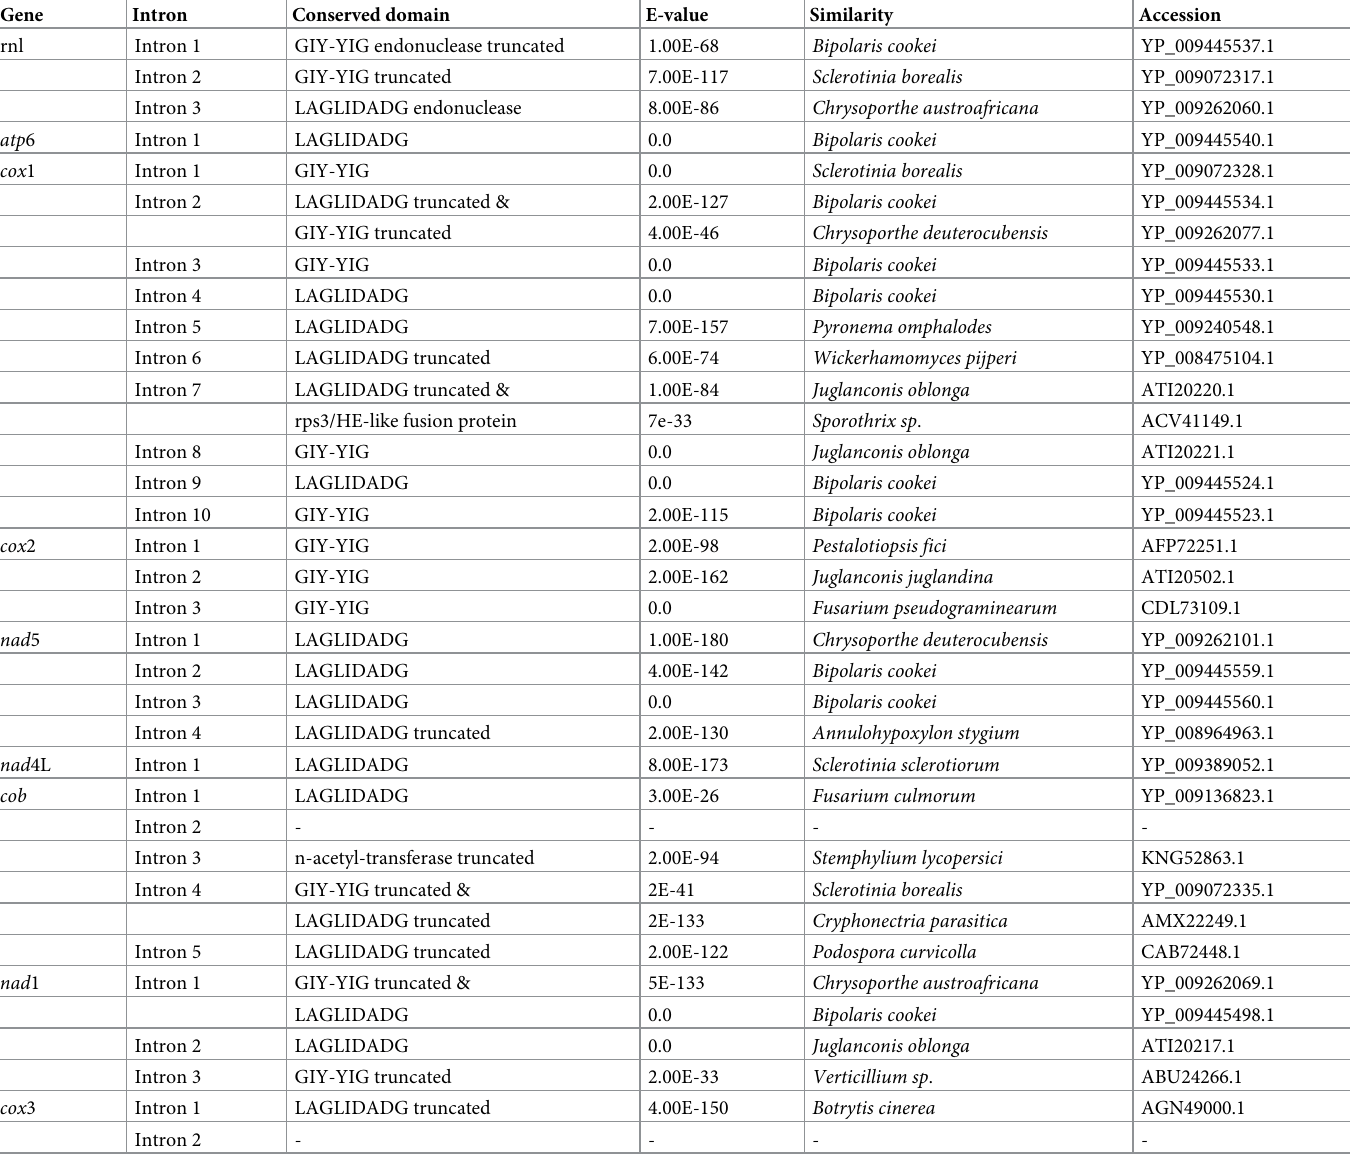
Table 2. Similarities of complete and truncated intron-encoded ORFs from the Coniothyrium glycines mtDNA to proteins in the non-redundant protein NCBI database (BLASTX <